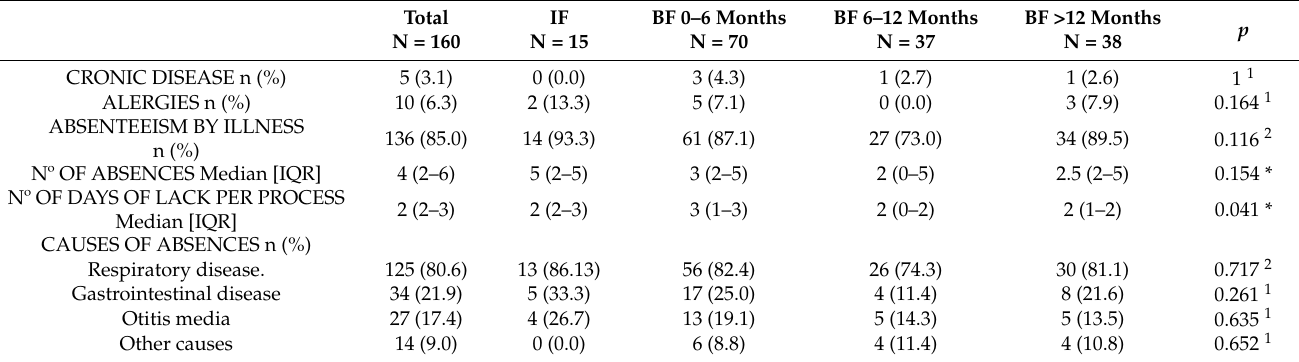
Table 3. School absenteeism and its causes.